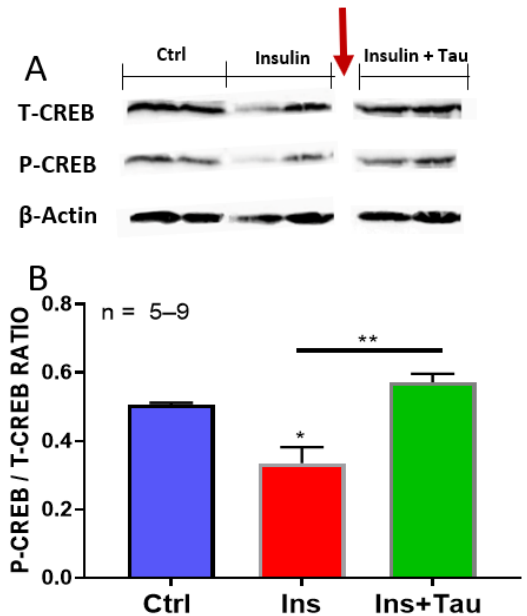
Figure 8. Western blot showing the effect of a 48-h treatment with insulin (80 µ U/mL) and insulin (80 µ U/mL) with taurine (20 mM) on the pCREB/pCREB ratio. Autoradiography ( A ) showing the ratio level of pCREB/tCREB ( B ) of ventricular cardiomyocytes in absence and presence of treat- ments, with insulin (80 μ U/mL) and with insulin (80 μ U/mL) + taurine (20 mM). The band corre- sponding to the tCREB and pCREB ( A ) were situated approximately at 43 kDA. The band corre- sponding to the β -actin ( A ) was situated approximately at 42 kDA. The red arrow indicates where the membrane was cut. The values are expressed as mean ± SEM. n is the number of wells. * p < 0.05 and ** p < 0.01.